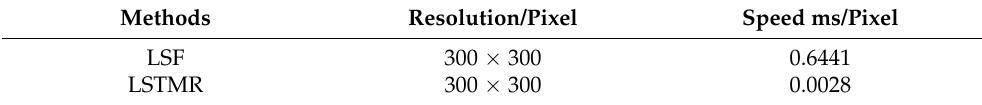
Figure 4. Linearity between the measured and calculated values of the optical properties in the simulation experiments, ( a ) is for the absorption coefficient and ( b ) is for the reduced scattering coefficient. Table 3. The speed of mapping from diffuse reflectance to optical properties.